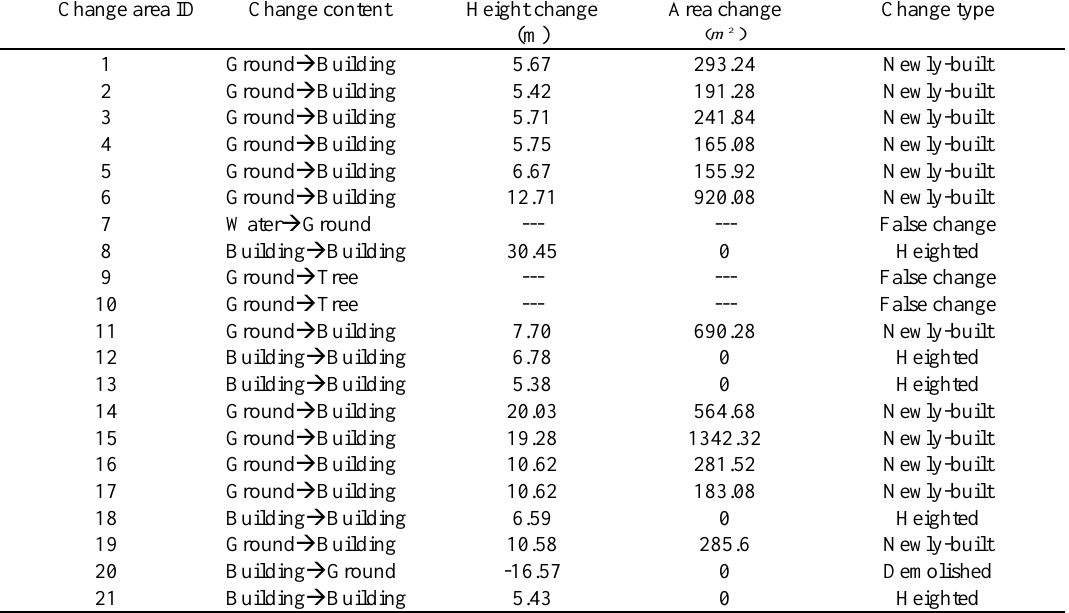
Table 2. Statistic of 3D building change detection